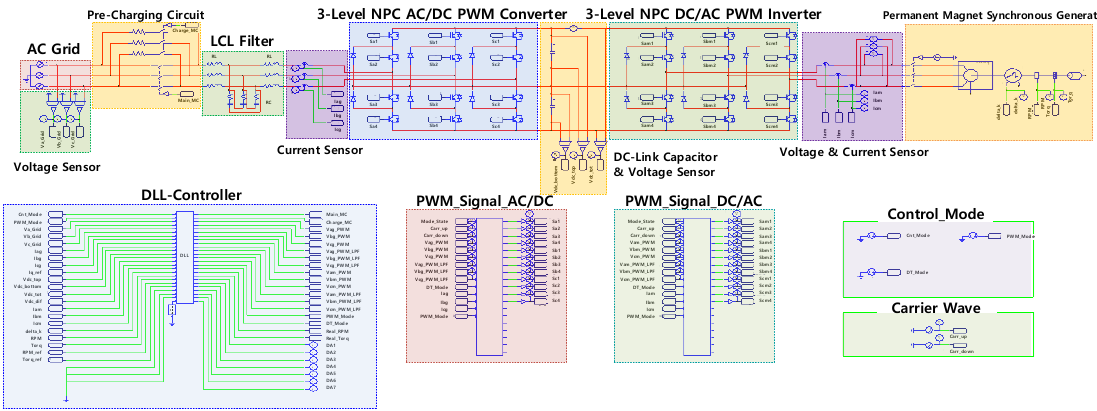
Figure 14. Three-level NPC VSI back-to-back schematic used in simulation. Table 3. Simulation